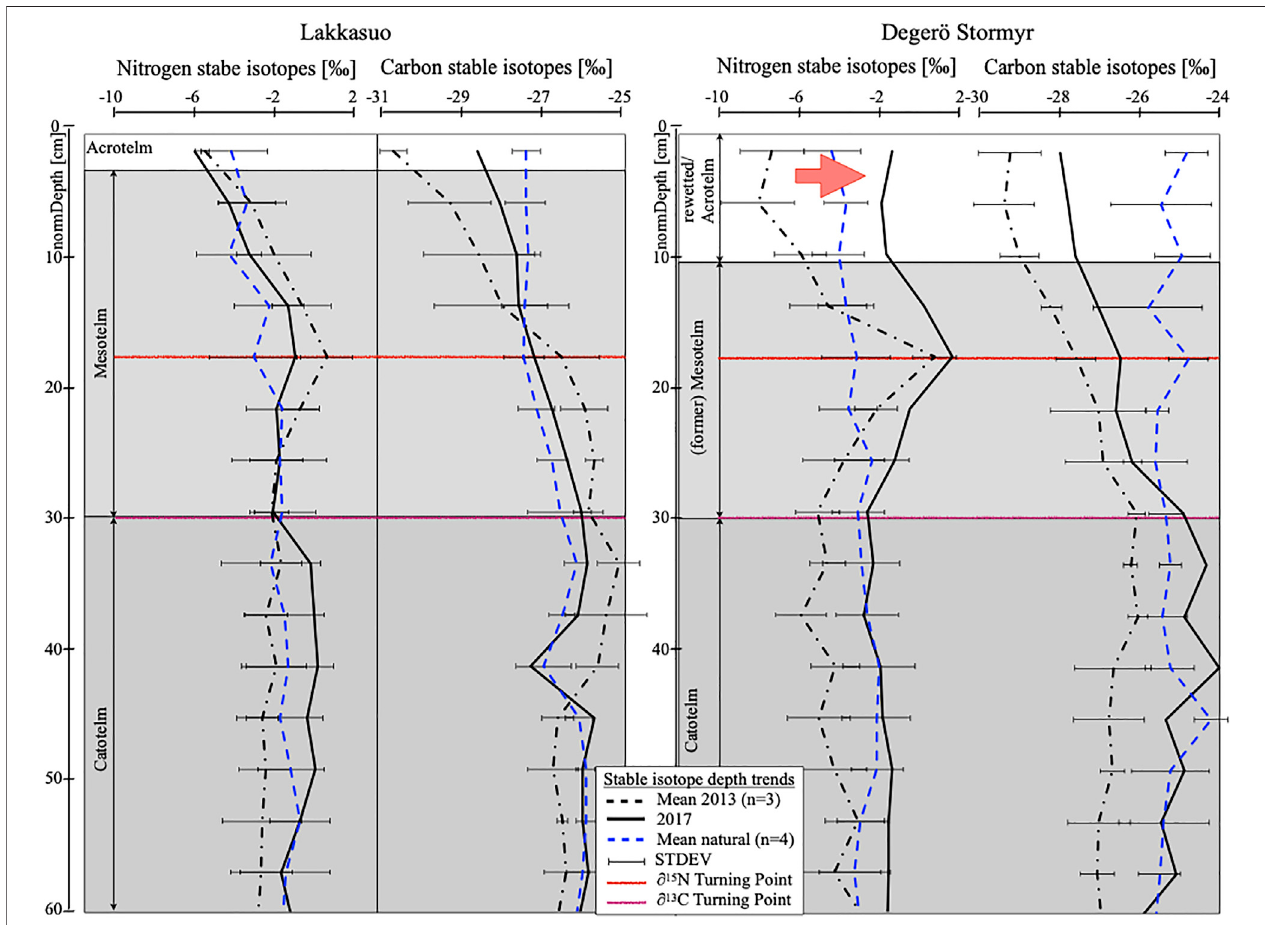
FIGURE 5 | Depth-normalized stable isotope trends (nitrogen, carbon) for Degerö Stormyr and Lakkasuo, separated for drained sites (2013 (black dotted) and 2017 (black)) and undrained sites (blue dotted); Red reference line gives the δ 15 N turning point, violet reference line gives the δ 13 C turning point; Note the shift between the nitrogen isotope depth trend from 2013 to 2017 in the rewetted Degerö Stormyr (marked with red arrow).